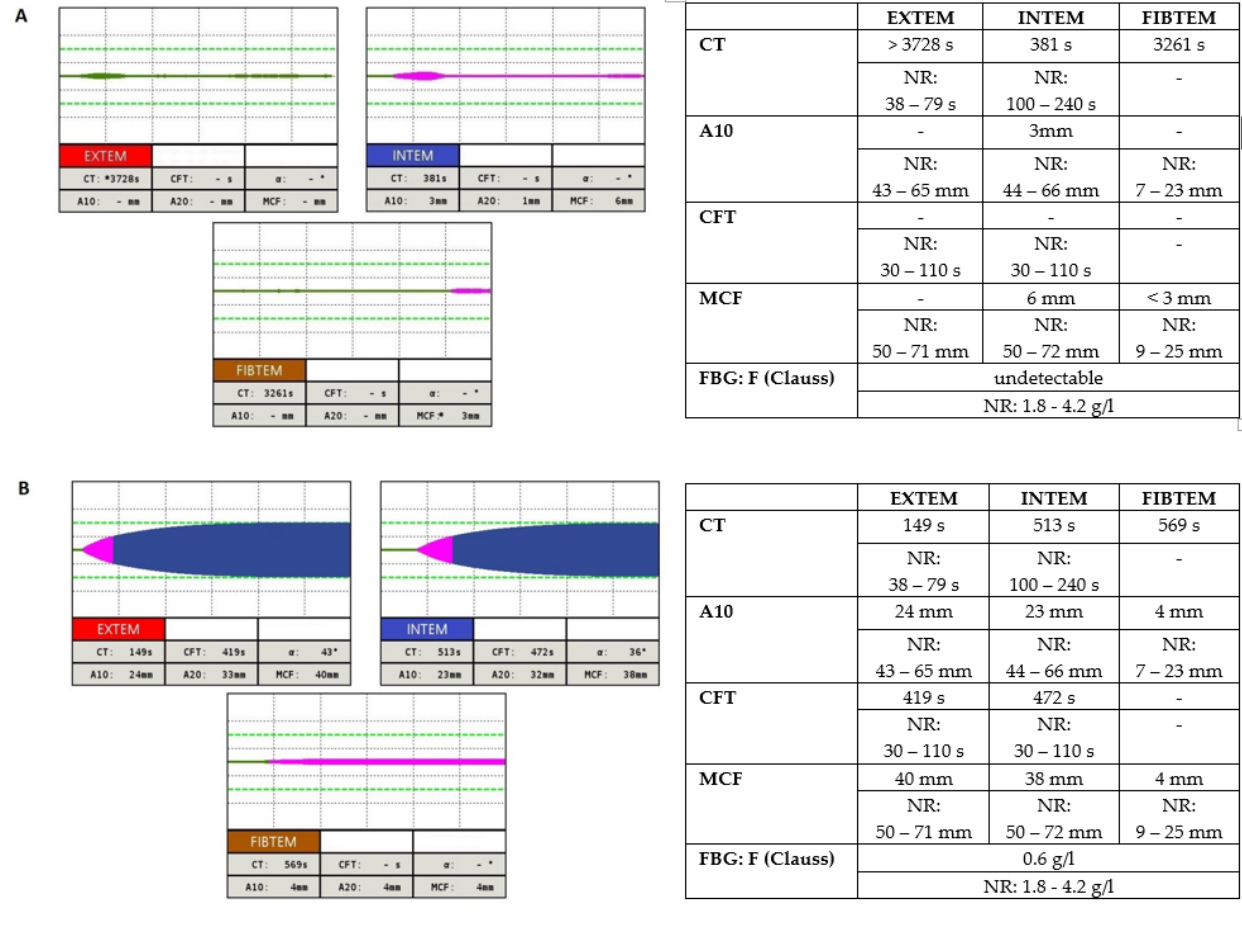
Figure 4. Rotational thromboelastometry (EXTEM, INTEM, FIBTEM) results and fibrinogen activity in the patient with afibrinogenemia from our center. ( A ) Basal level; ( B ) 30 min after administration of 24 mg/kg fibrinogen concentrate (Haemocomplettan ® P.